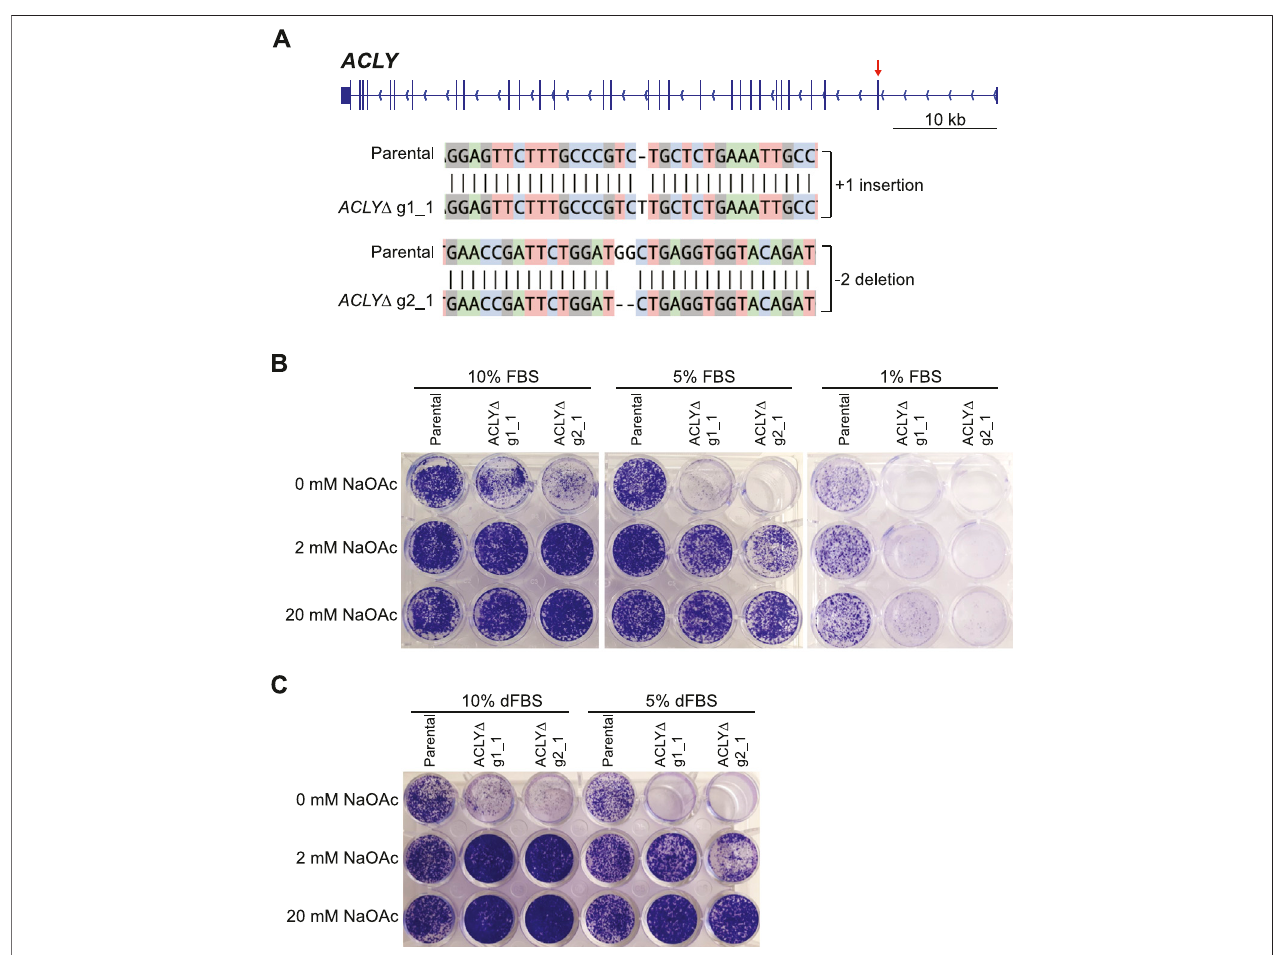
FIGURE 2 | Establishment of a nutritional model enabling Kac signaling modulation. (A) Overview of ACLY and sequencing data from the HEK293 ACLY Δ clones selectedforfurthercharacterization.Theredarrowindicatesthe fi rstexon,whichwastargetedusingtwoindependentgRNAs.AlignmentsweregeneratedusingCRISP- ID (Dehairs et al., 2016). (B) Clonogenic assays of HEK293 ACLY Δ and parental cells incubated with and without NaOAc in medium containing 1, 5, or 10% FBS. (C) Clonogenic assay of HEK293 ACLY Δ and parental cells incubated with and without NaOAc in medium containing 5 or 10%